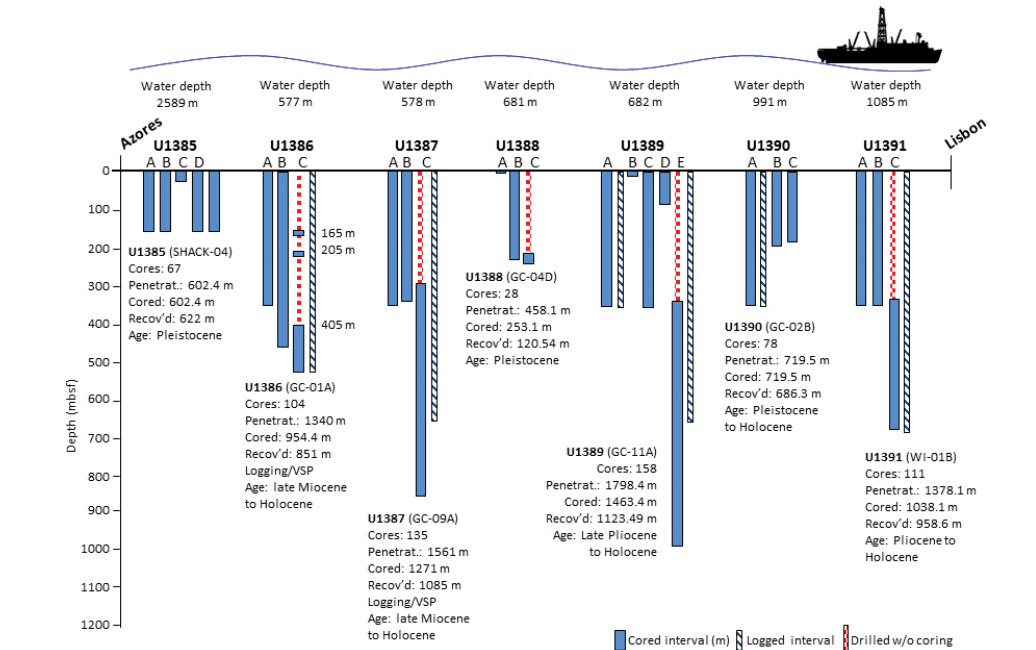
Figure 3. Expedition 339 sites information. 19 holes (681 cores) were drilled on 46.1 days on site, with a penetration of 7857.4m, cored 6301.6 and recovered 5446.7m